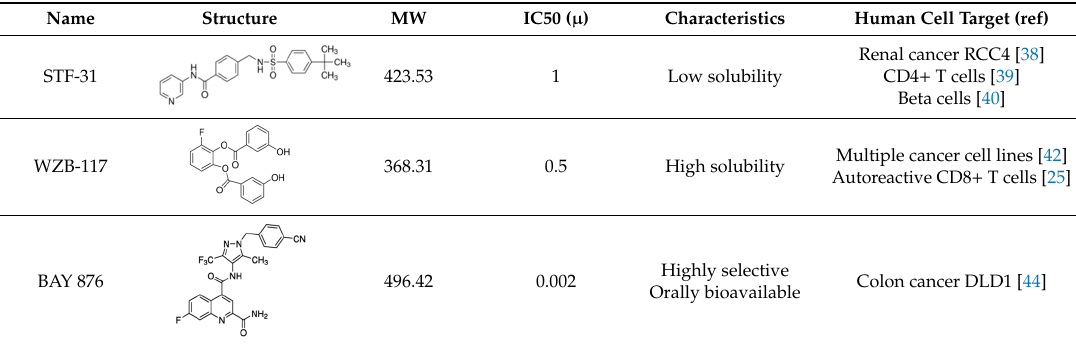
Table 1. List and principal characteristics of small molecules that act as Glut1 inhibitors.